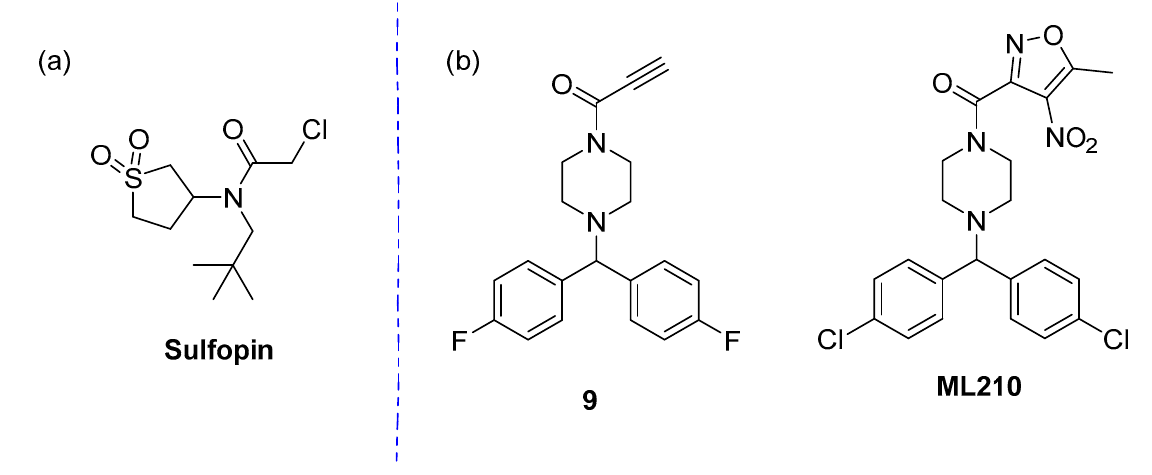
Figure 6 . ( a ) Structure of sulfopin; ( b ) Structures of GPX4 covalent binders. Figure 6. ( a ) Structure of sulfopin; ( b ) Structures of GPX4 covalent